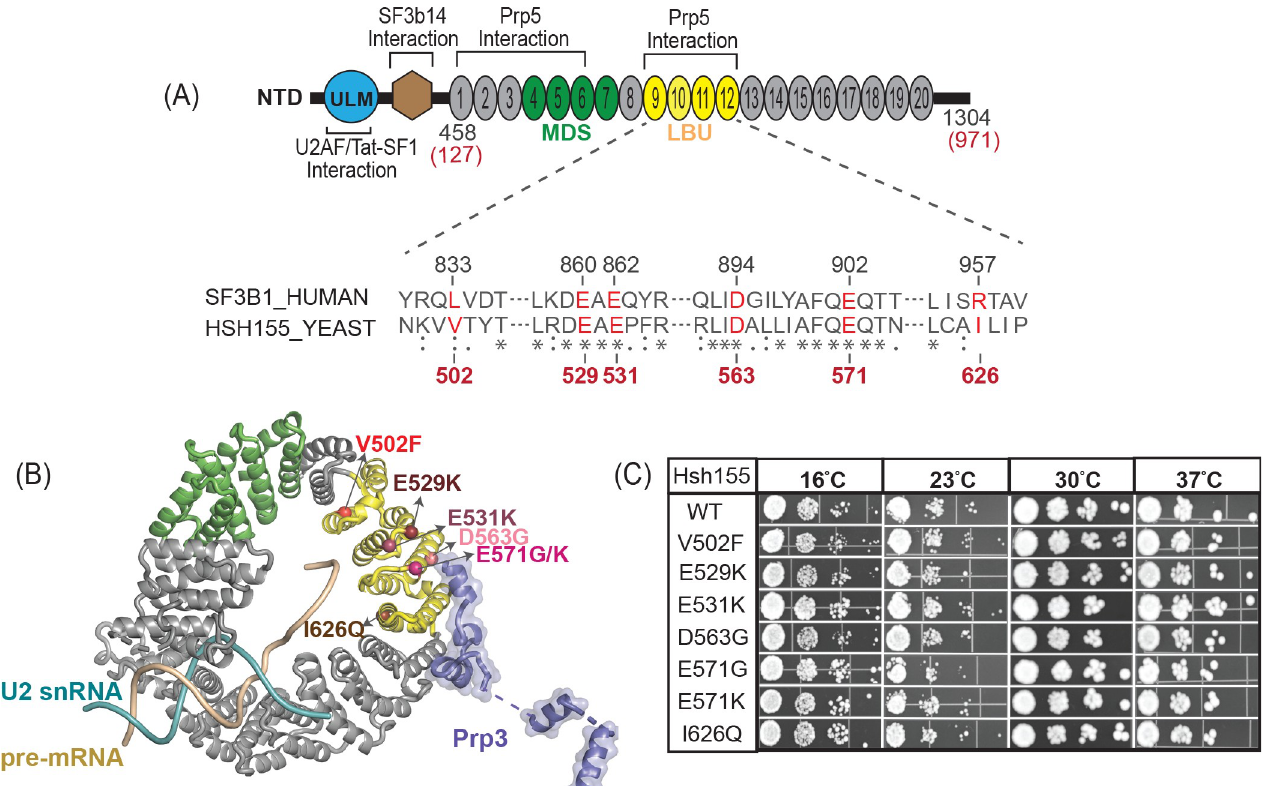
Fig 1. LBU-mutants of Hsh155 do not affect cellular proliferation. (A) Schematic of the domain architecture of SF3b1. HR4-7 (green) is a hotspot region for mutations associated with MDS, and LBU-mutants are found in HR9–12 (yellow). The bottom panel shows the alignment of sequences from H . sapiens and S . cerevisiae . The LBU-mutants studied here are shown in red. The sequence alignment was generated using EMBOSS Needle [40]. (B) SF3b1 LBU mutations mapped to the yeast Hsh155 structure in the B complex spliceosome (PDB:5NRL). Spheres represent the mutations present in HR9-12. Hsh155 HR11-13 are proposed to interact with splicing factor Prp3, which is a component of tri-snRNP. (C) Temperature sensitivity growth assays of Hsh155 LBU-mutant strains plated on YPD. Successive 10-fold dilutions of OD 600 = 0.5 cultures are shown. Growth assays were carried out in triplicate.